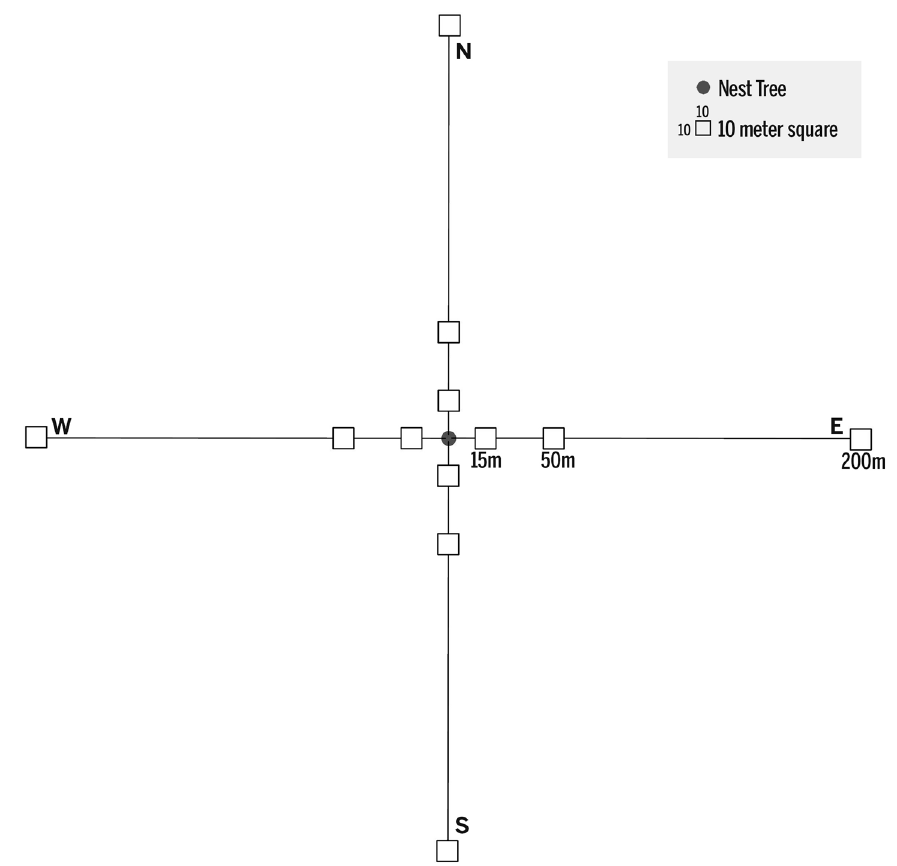
Figure 3. Snag basal area plot arrangement.